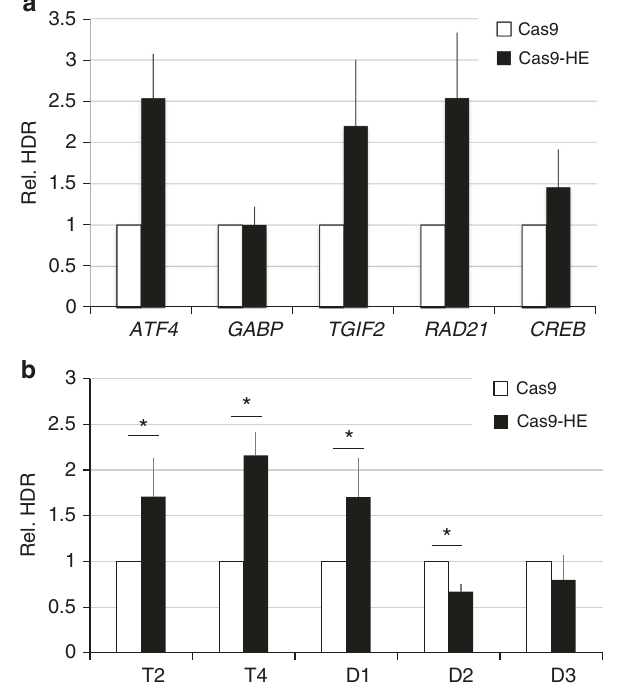
Fig. 5 HDR stimulation by the HE domain takes place at different target genes and can depend on the guide RNA used. a Relative frequencies of HDR induced by Cas9 – HE were compared to those induced by Cas9 at fi ve different target genes in HEK293 cells using previously published guide RNAs and donor plasmids 36 . Targeted integration of the donor plasmid results in in-frame insertion of E2A - neoR cDNA 36 . G418 (neomycin)-resistant colonies were counted after Cresyl violet staining to measure HDR-mediated events and normalized by the number of colonies obtained with Cas9 to give the relative HDR frequencies indicated. Data represented are from three independent experiments for TGIF2 , RAD21 , and CREB genes and from four experiments for ATF4 and GABP genes and are provided in Supplementary Fig. 7. Error bars indicate standard deviation. b Relative frequencies of HDR induced by Cas9 – HE were compared to those induced by Cas9 with the indicated guide RNAs, which all cleave to a small 50-bp region of the AAVS1 locus, and a common p84 Δ donor plasmid, harboring ~800-bp homology arms. P84 Δ was derived from the p84 donor plasmid depicted in Fig. 1a by shortening the homology arms so that they would not be cleaved by any of the guide RNAs. Asterisks indicate that the difference is statistically signi fi cant when comparing Cas9 – HE to Cas9 in t -test (* P <0.05). Data represented are from fi ve independent experiments and are provided in Supplementary Fig. 7. Error bars indicate standard